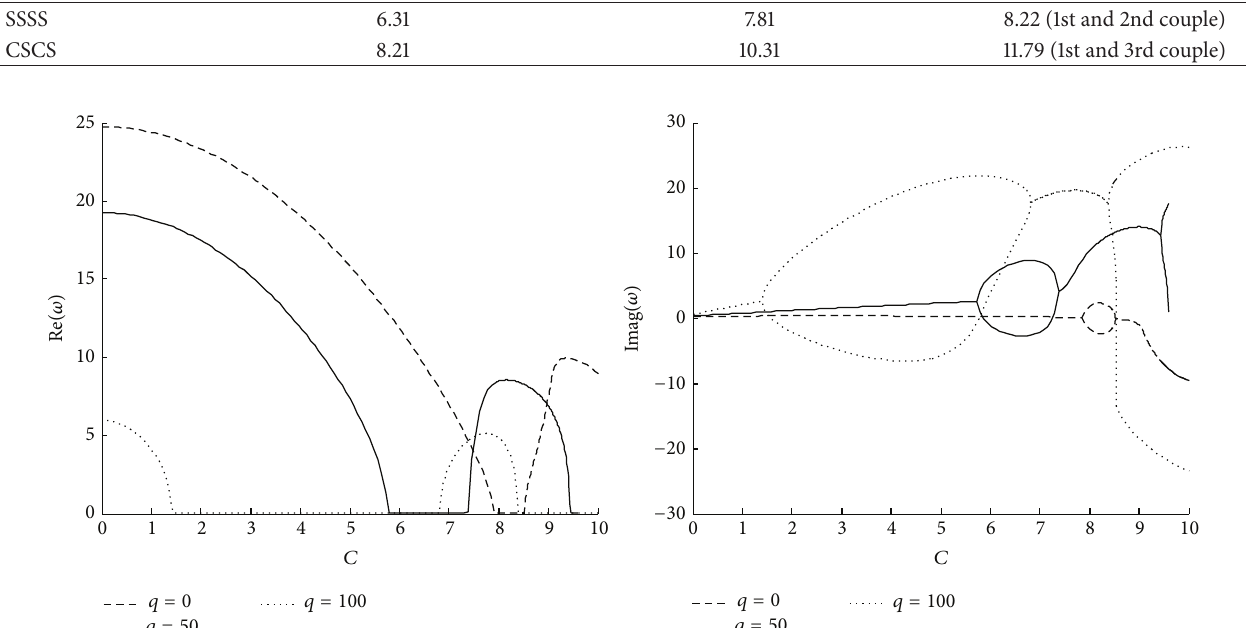
Figure 7: Dimensionless complex frequencies versus dimensionless axially moving speed 𝐶 (𝐻 = 10 −3 , 𝑟 = 1 , 𝑈 = 10 , and 𝜆 = 0.05 ).